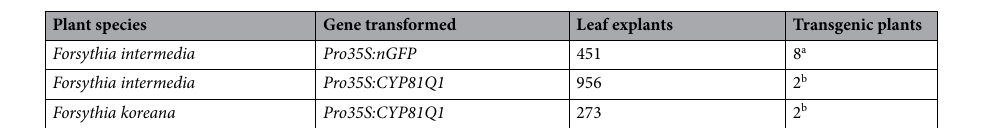
Table 1. Summary on the generation of transgenic Forsythia plants. a Kanamycin-resistant plants presenting GFP fluorescence. b Kanamycin-resistant plants presenting expression of the CYP81Q1 gene in RT-PCR